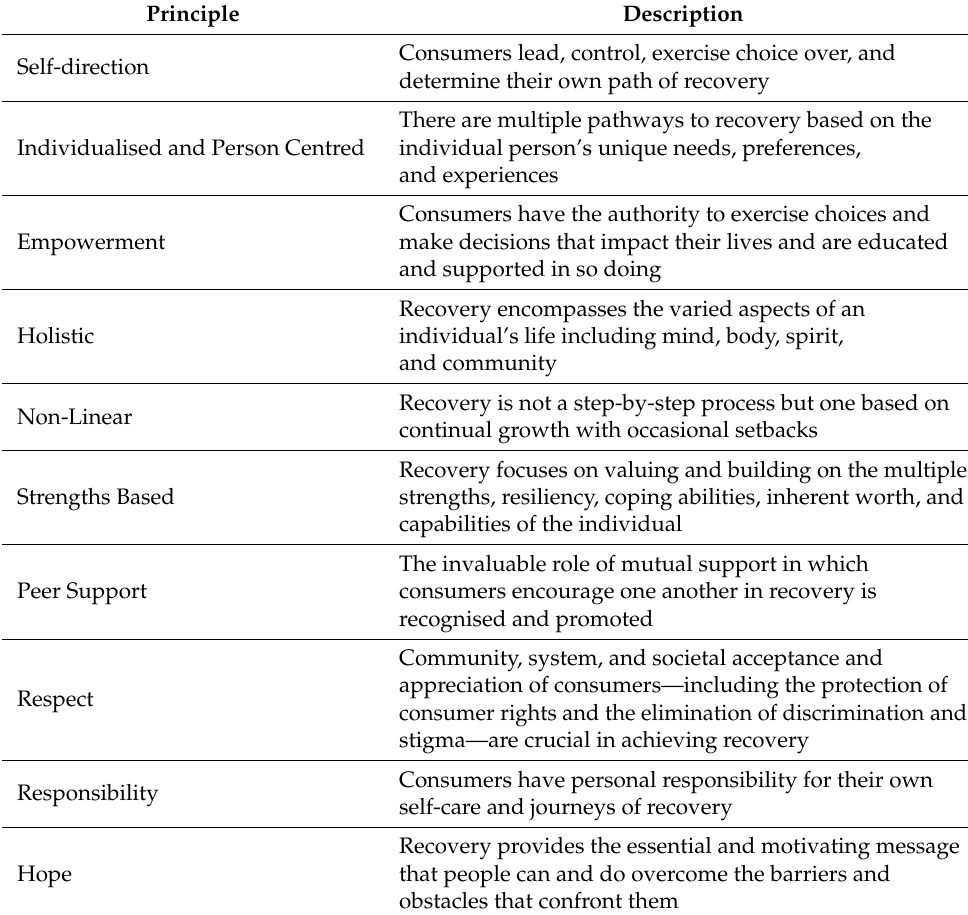
Table 2. Consensus statement for recovery